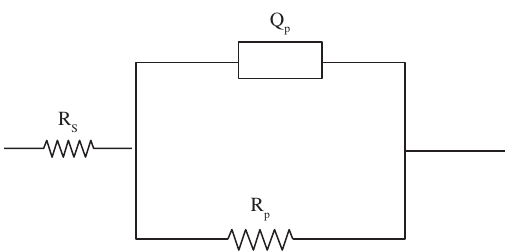
Figure 14. Equivalent circuit obtained from fitting and simulation of Bode plots in Figure